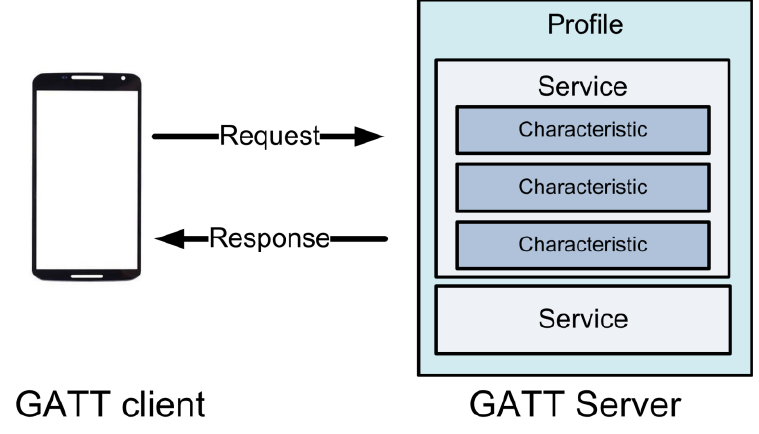
Figure 4. A diagram of the Generic Attributes (GATT) server.